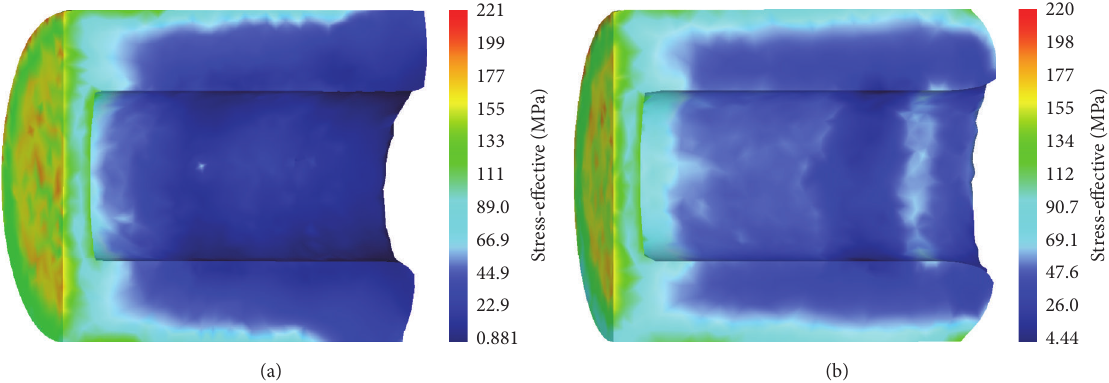
Figure 15: Stress field distribution of billet deformed at the friction coefficient of (a) 0.5 and (b) 0.7.